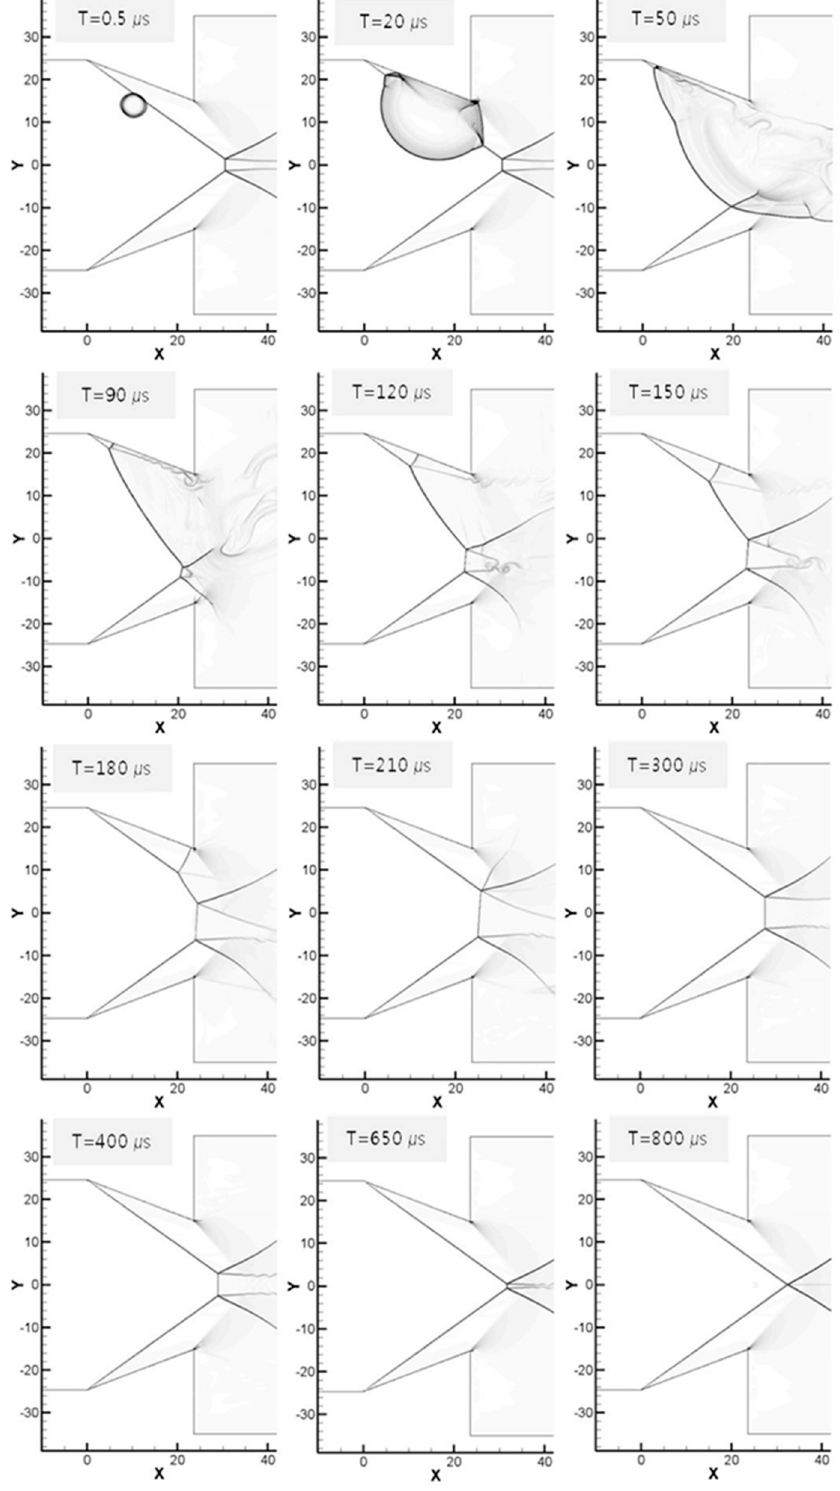
Figure 13. Interaction between blast wave and oblique shock, deposition at the middle of the upper wedge. Energy: 215.0 mJ.